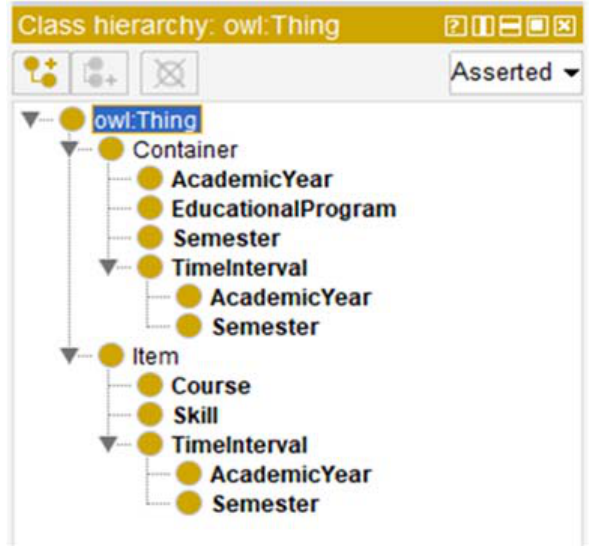
Figure 6. Class hierarchy of the ontology developed.